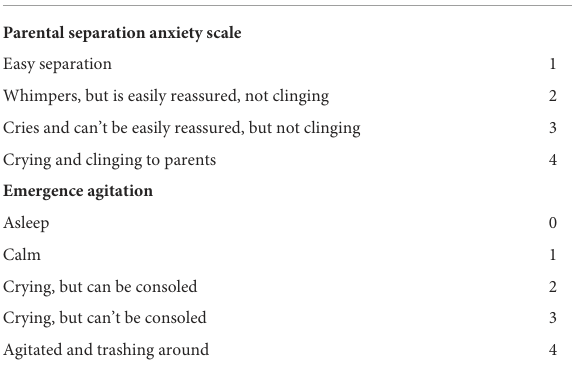
TABLE 1 Evaluation criteria for parental separation anxiety scale, emergence agitation. Performance